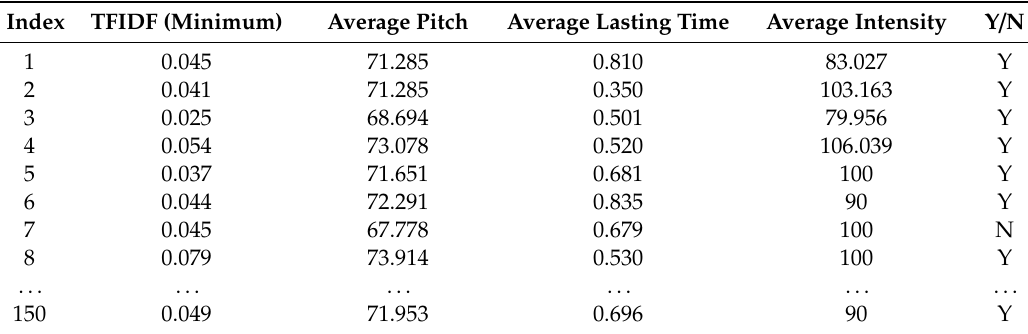
Table 2. Results of extracted melody tracks.